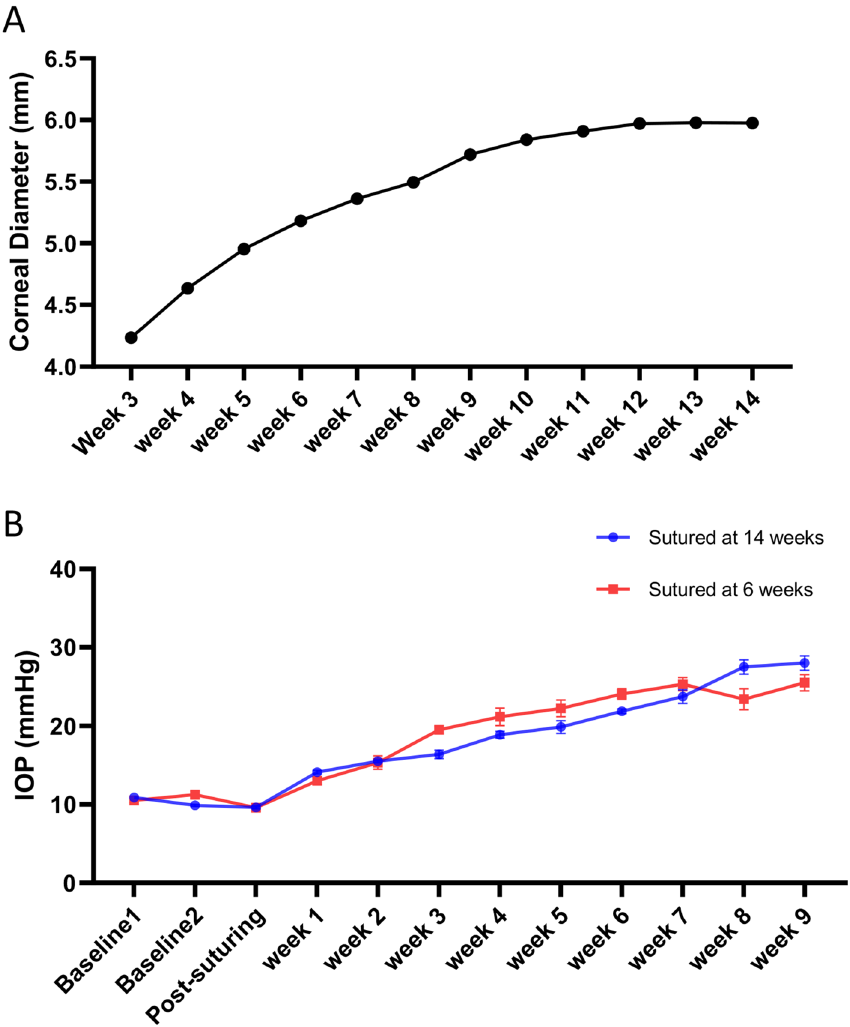
Figure 5. Eye growth does not contribute to increased IOP in the gOHT model. ( A ) Average corneal diameter was measured from 3 weeks of age until it plateaued at 12–14 weeks. Note the range of measured values were too narrow to display error bars (n = 8). ( B ) IOP measurements from eyes sutured at 14 weeks (n = 8) show the same increased IOP trend as eyes sutured at 6 weeks (n = 12, bars are